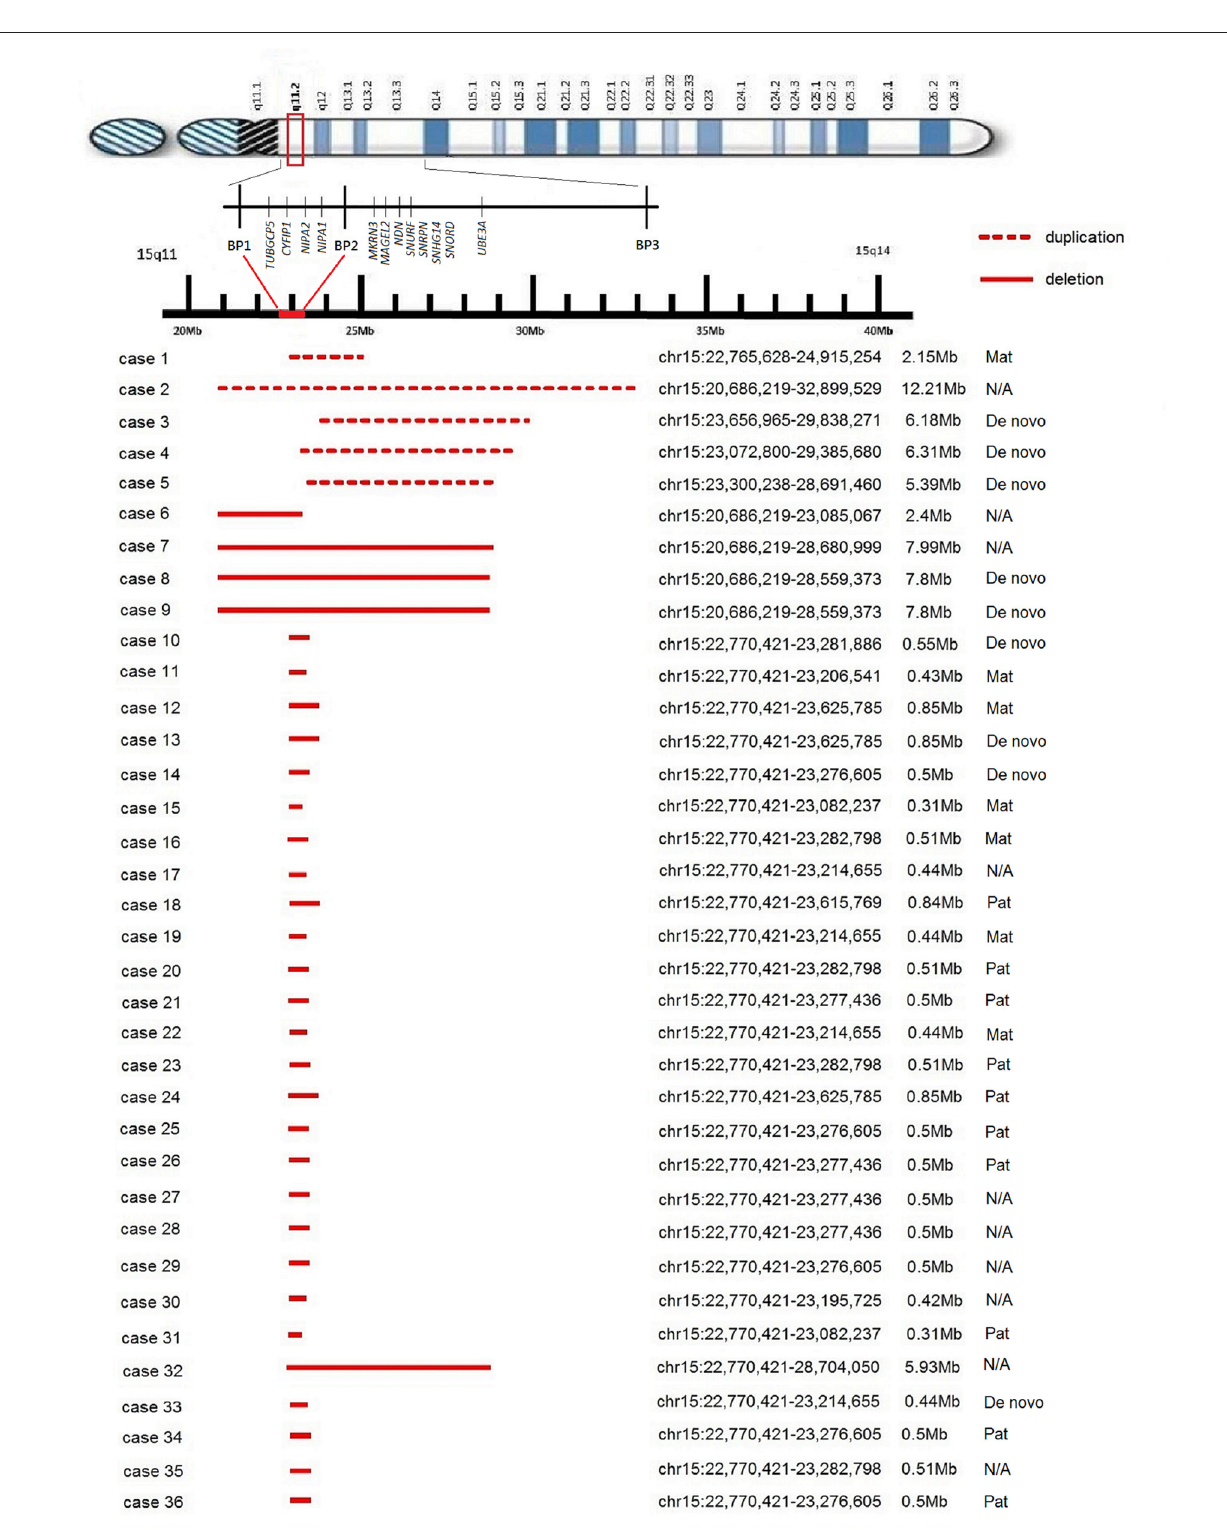
Frontiers in Medicine |